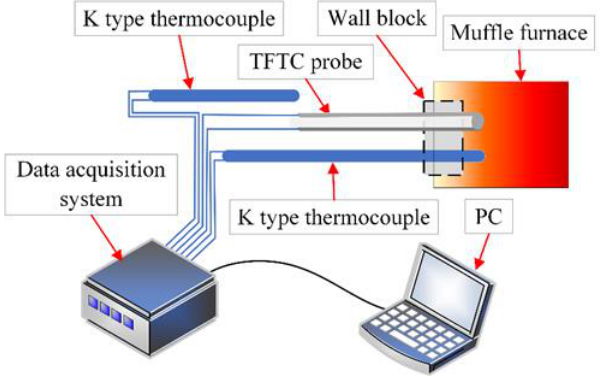
Figure 6. Calibration system of the thin-film thermocouple probe.